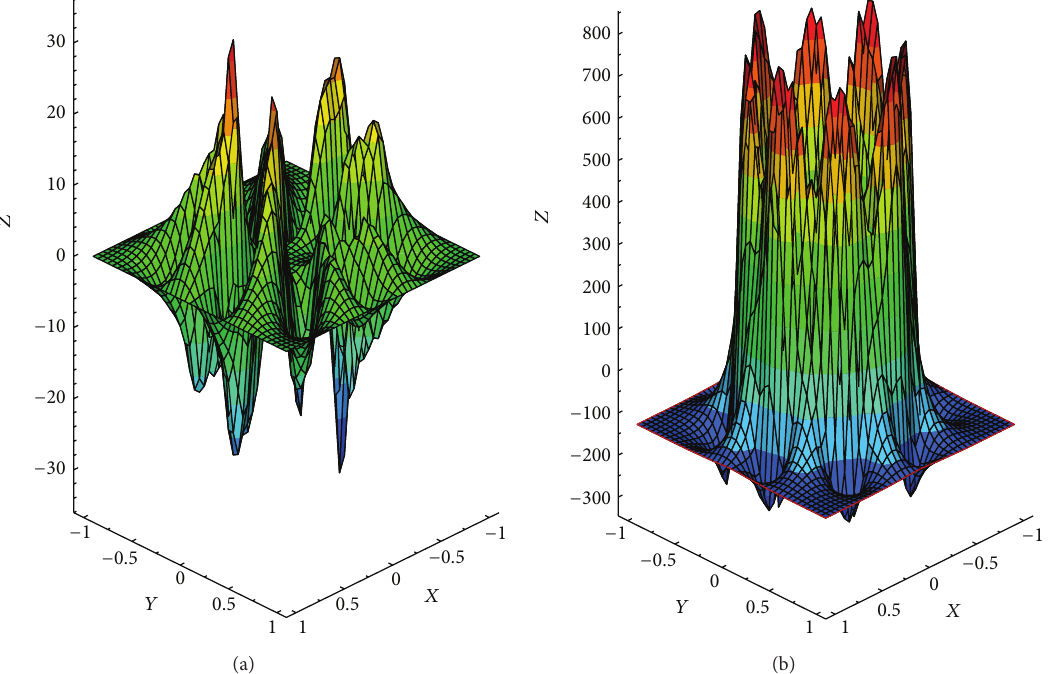
Figure 3: Velocity and pressure fields at time 𝑡 = 0 . With 𝜇 = 1 , stiffness efficient 𝑐 𝑠 = 100 : (a) 𝑥 -component velocity field; (b) pressure field.